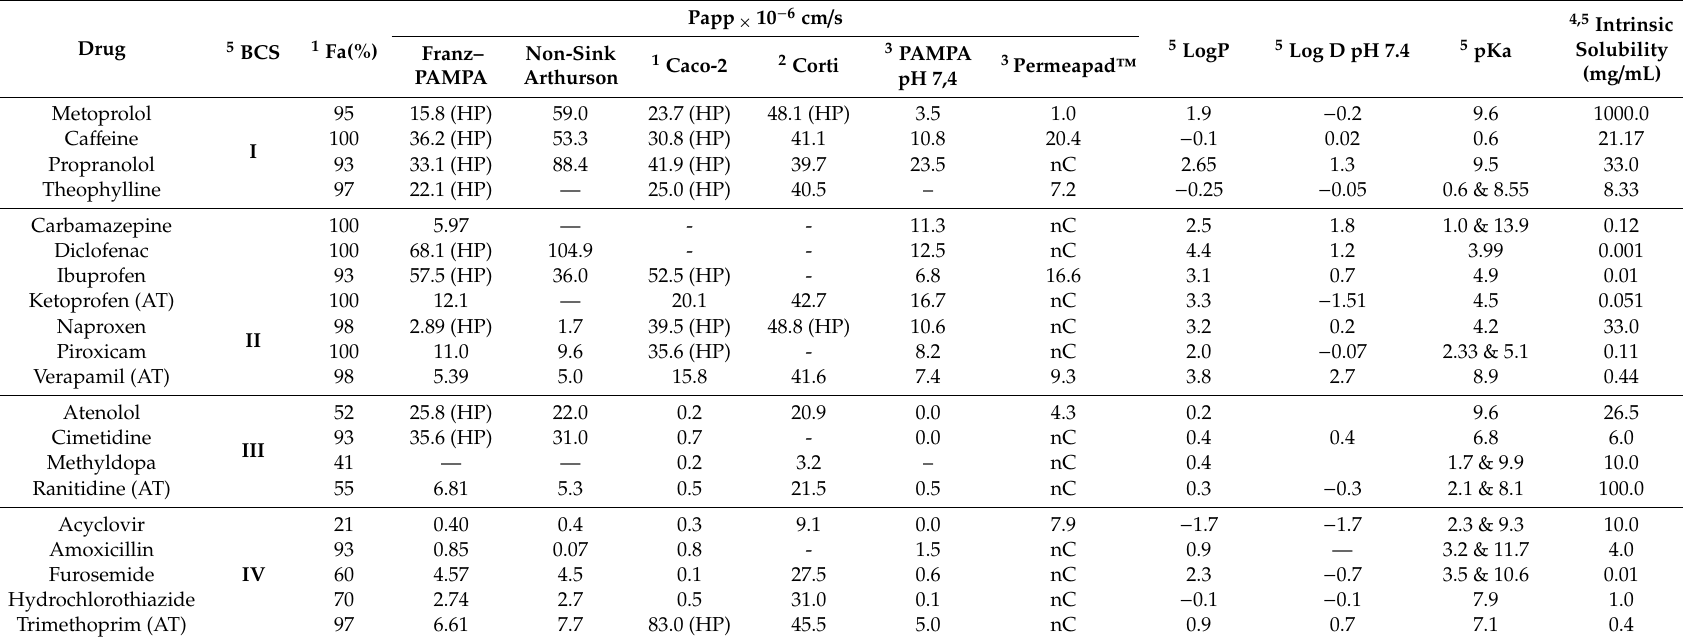
Table 2. Papp calculated values in Franz-PAMPA and using Non-Sink Artursson equation. BCS classification of studied drugs and literature data to all other parameters.